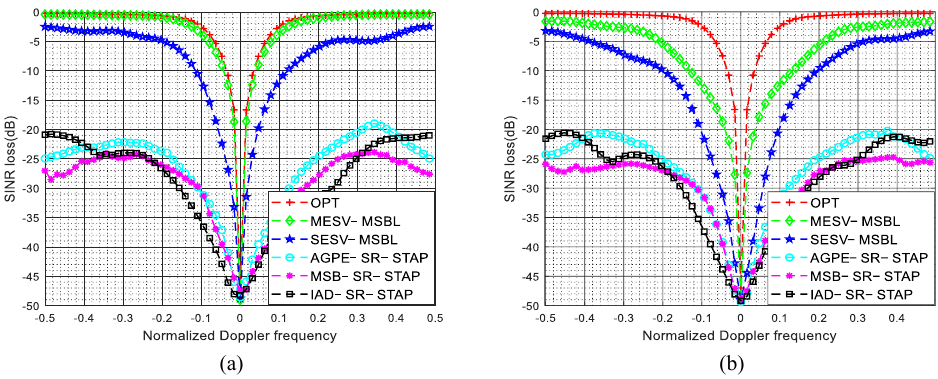
Figure 16. SINR loss comparison of different methods in the presence of arbitrary array errors and intrinsic clutter motion. ( a ) σ v = 0.5 m/s; ( b ) σ v = 3